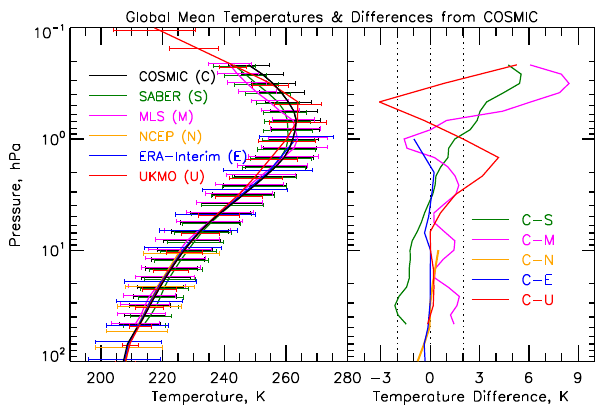
Fig. 6. Left: Global mean temperatures from COSMIC (C), SABER (S), MLS (M), NCEP (N), ERA-Interim (E) and UKMO (U). Right: Differences from the COSMIC global mean